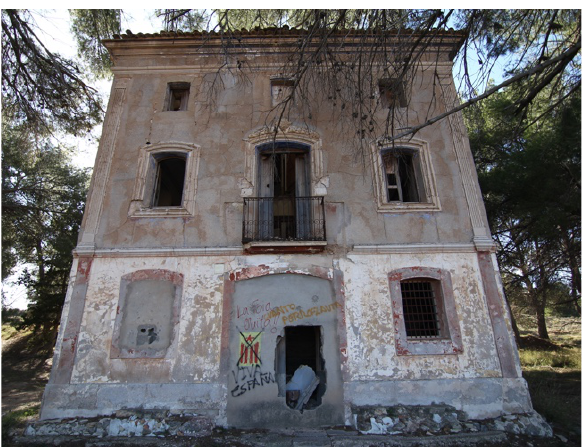
Figure 21. Current view of the main façade facing the river. The two lateral façades repeated the composition of the main façade –basement, pilasters and entablature–, varying the number and dimensions of the moulded openings and with a moulded circle on the geometric centre filling the space left by the windows (Figure 22). All the architectural pieces (bases, pilasters, capitals, mouldings and cornices) were made with white plaster, using blood red colour for the ground floor, grey colour for the other two floors and blue colour for the cornice of the